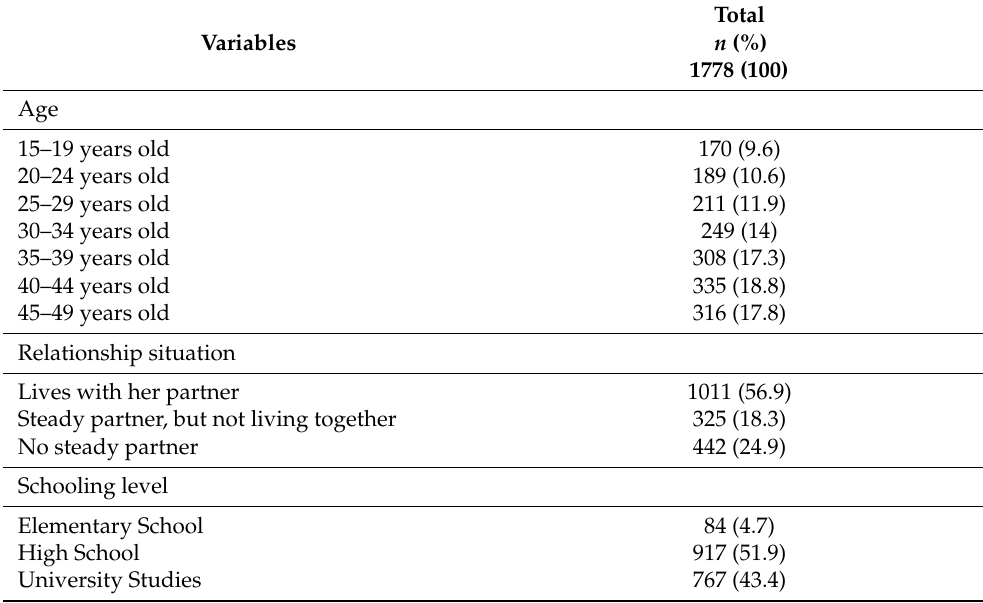
Table 1. Sociodemographic